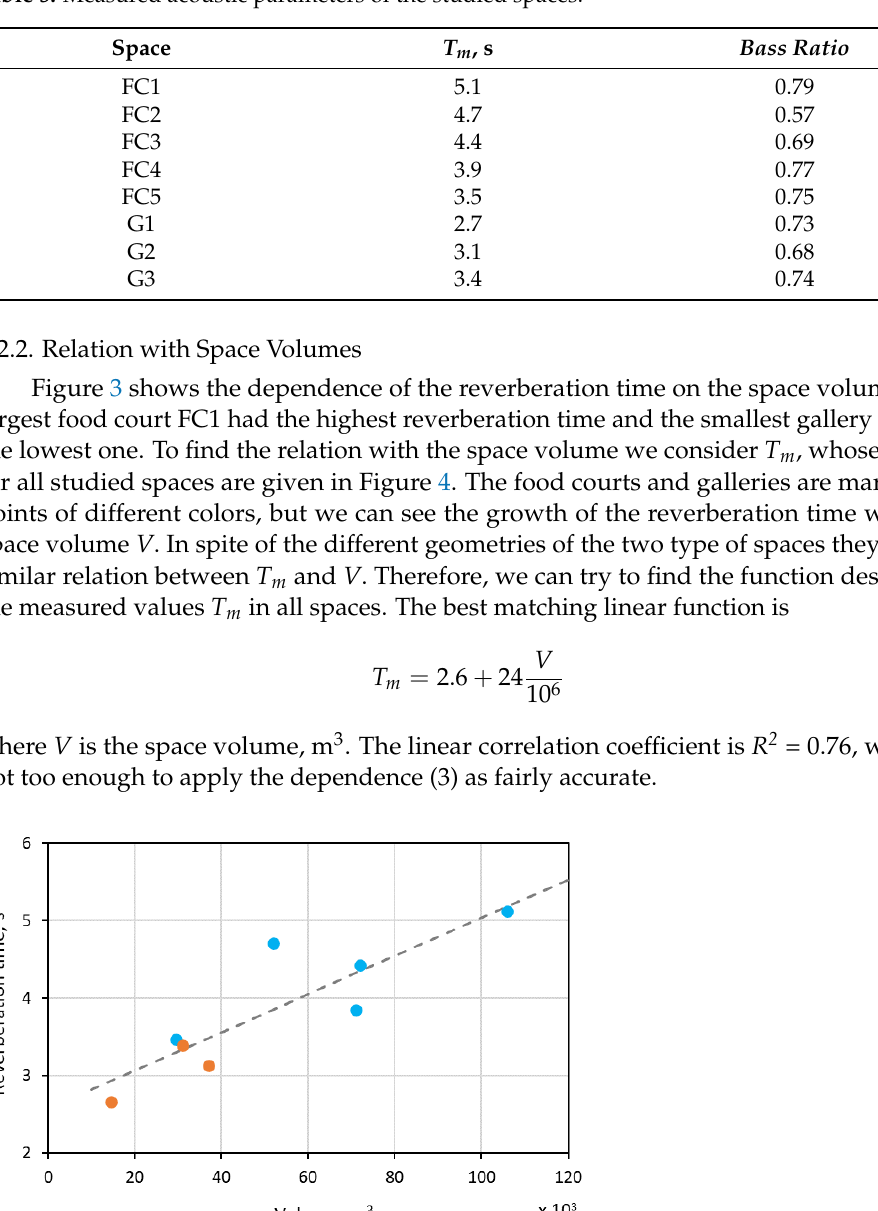
Table 5. Measured acoustic parameters of the studied spaces.